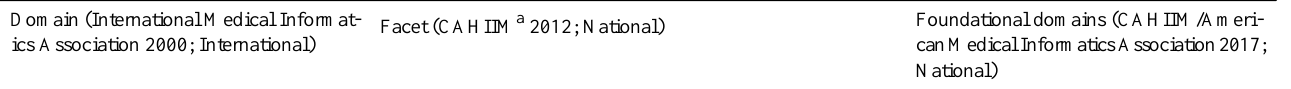
Table 1. The evolution of curriculum requirements for health informatics